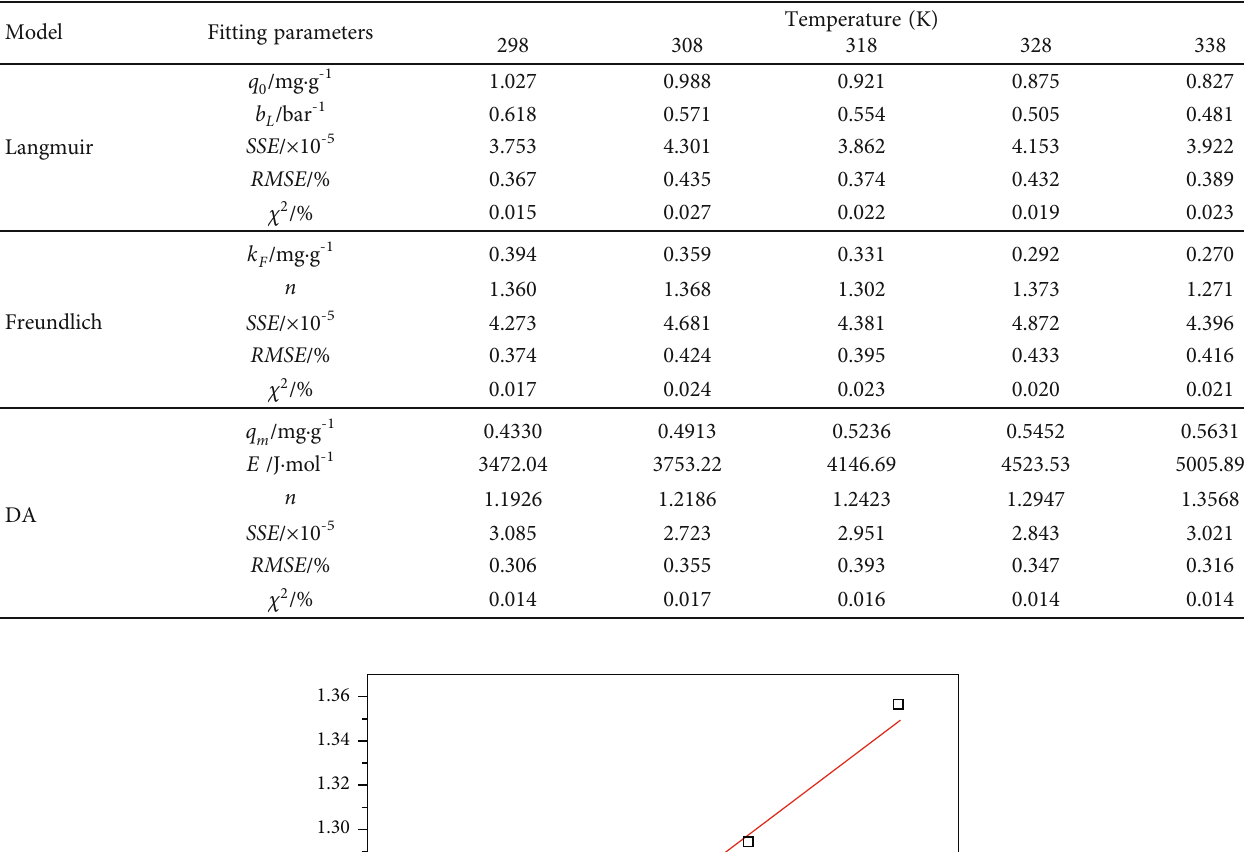
Table 1: Fitting results of the studied isotherm